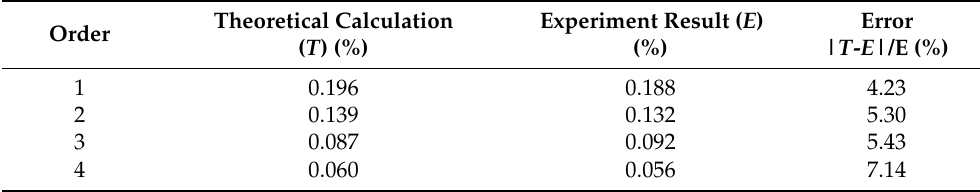
Table 4. The first four order damping loss factor of the sandwich plate obtained by the presented method and experiment.